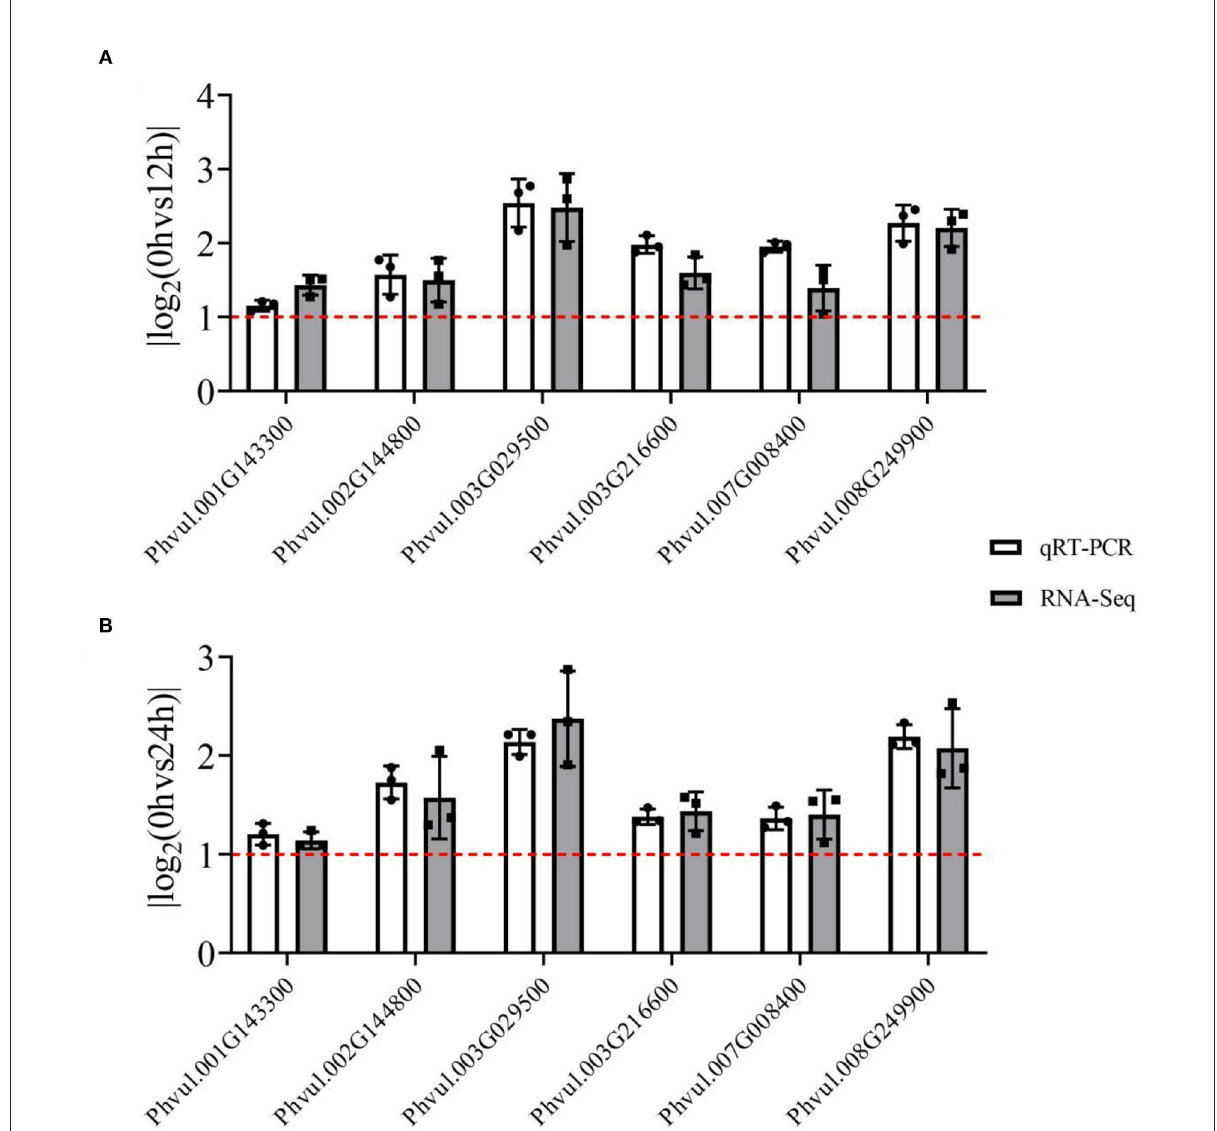
FIGURE7 The qRT-PCR analysis of RNA-seq results of six differentially expressed genes (DEGs) from enriched pathways. The white grids represent the qRT-PCR results, while the gray grids represent the RNA-seq results. The red line represents the value of the |log2(FoldChange)|; a value > 1 indicates that the genes were DEGs. Each black point represents the average value of replicates. (A) The |log2(FoldChange)| value of 3d + S-0h vs. 3d + S-12h; (B) the |log2(FoldChange)| value of 3d + S-0h vs. 3d + S-24h.